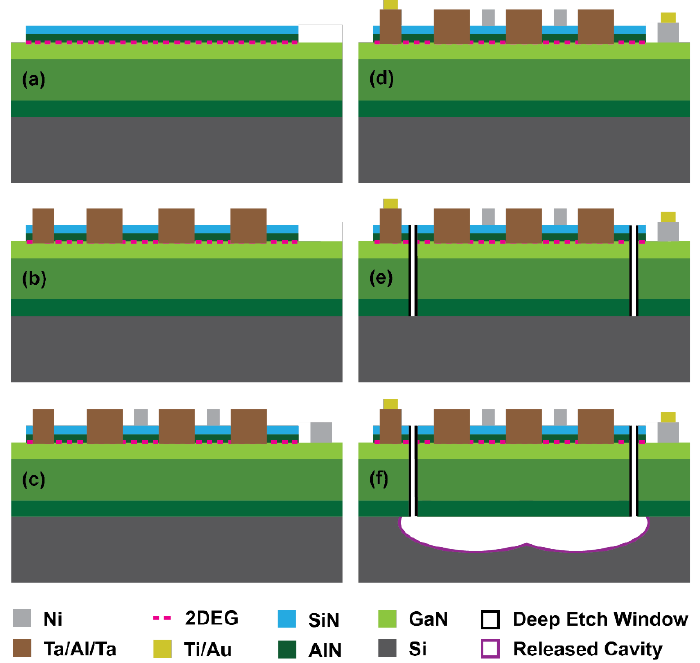
Figure 2. Fabrication process steps of switchable GaN MEMS resonators. ( a ) Mesa isolation. ( b ) Ohmic (Ta/Al/Ta) metallization and annealing. ( c ) Schottky (Ni) metallization. ( d ) Pad (Ti/Au) metallization. ( e ) Deep etch. ( f ) Isotropic release.